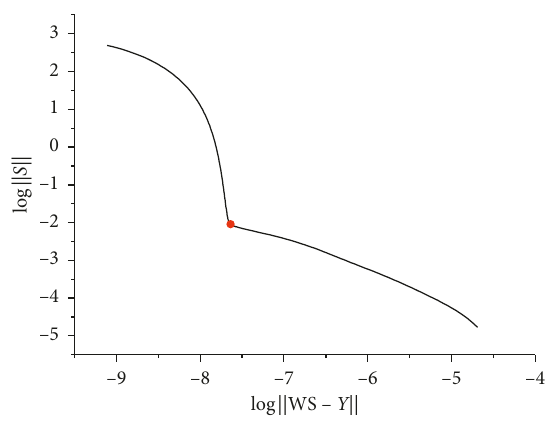
Figure 5: The L-curve plot of F